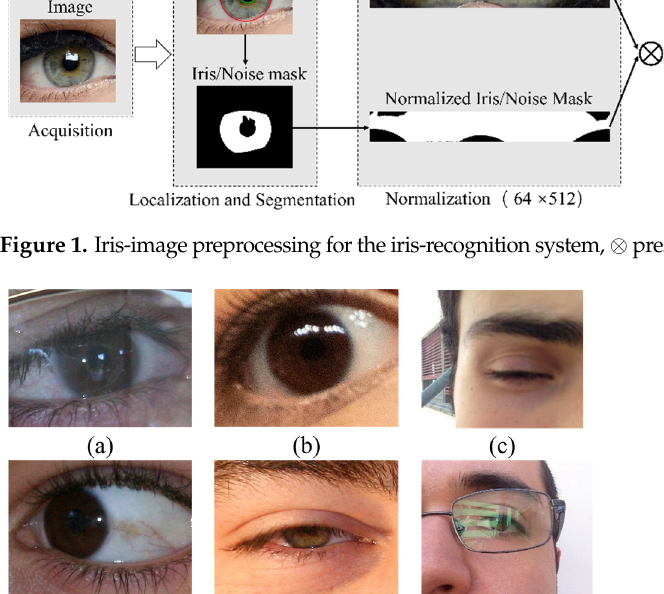
Figure 2. Example of degraded iris images: ( a ) glasses occlusion, ( b ) blur, ( c ) absence, ( d ) gaze deviation, ( e ) eyelid occlusion, and ( f ) specular reflection.